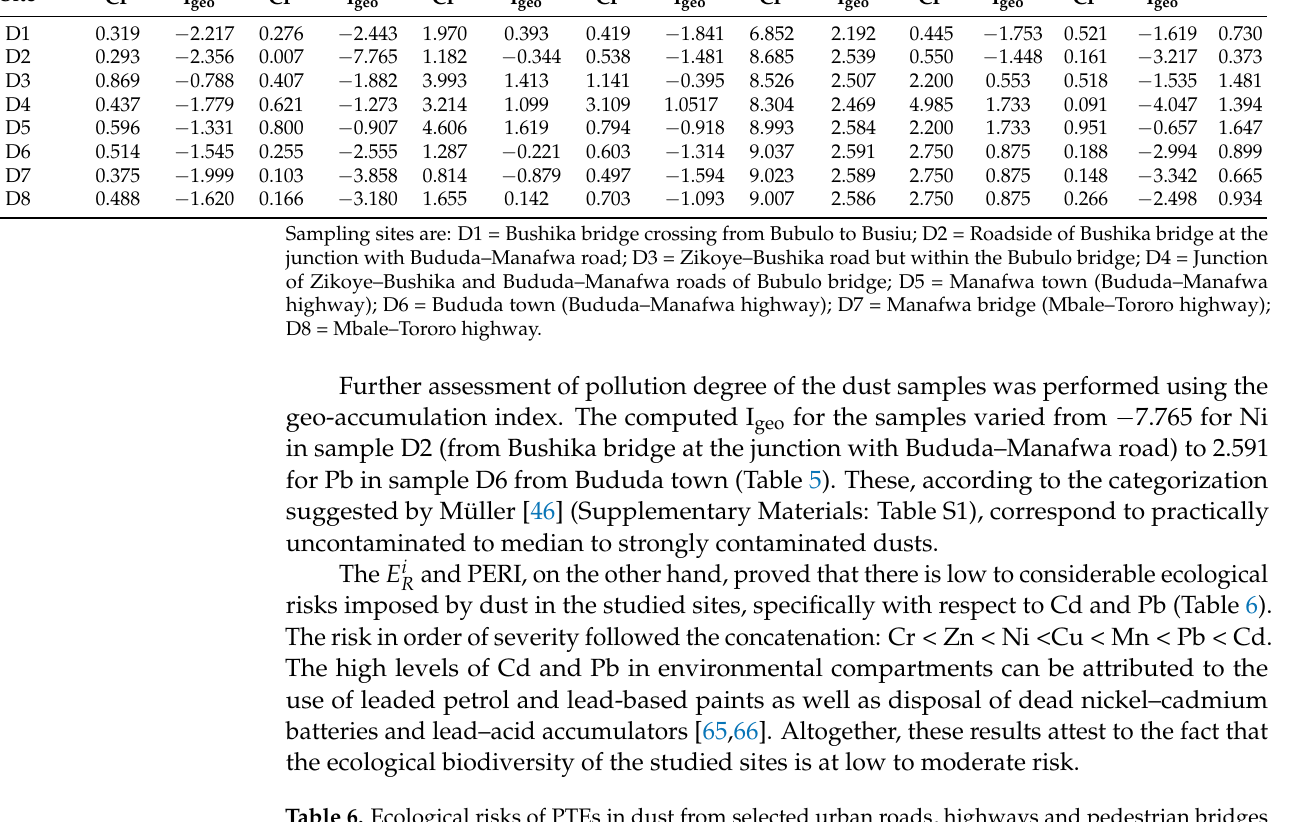
Table 6. Ecological risks of PTEs in dust from selected urban roads, highways and pedestrian bridges in Eastern